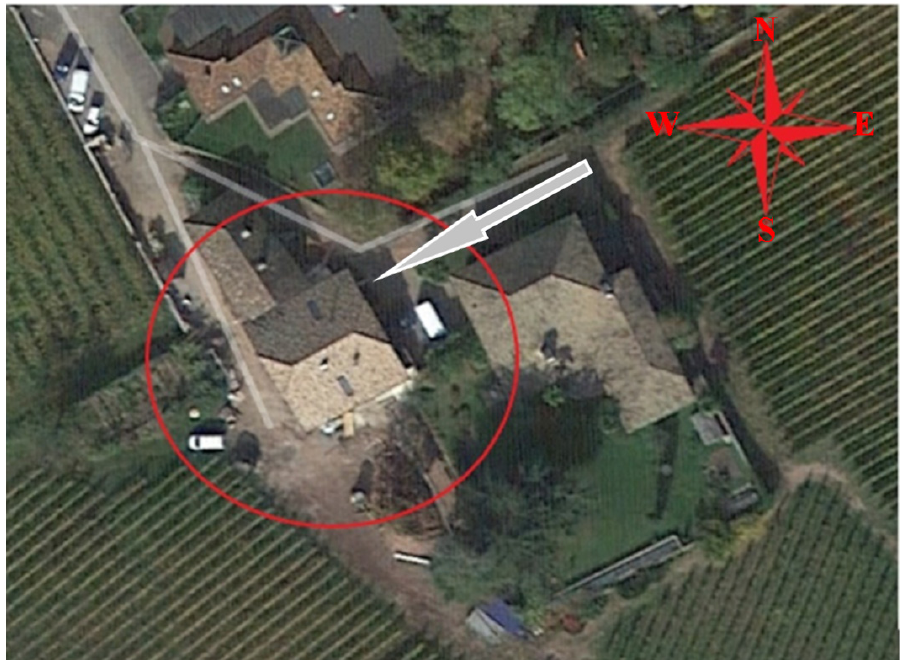
Figure 2. Plan overview of the analyzed building. The location of the wall that was examined for this study is indicated by the arrow.